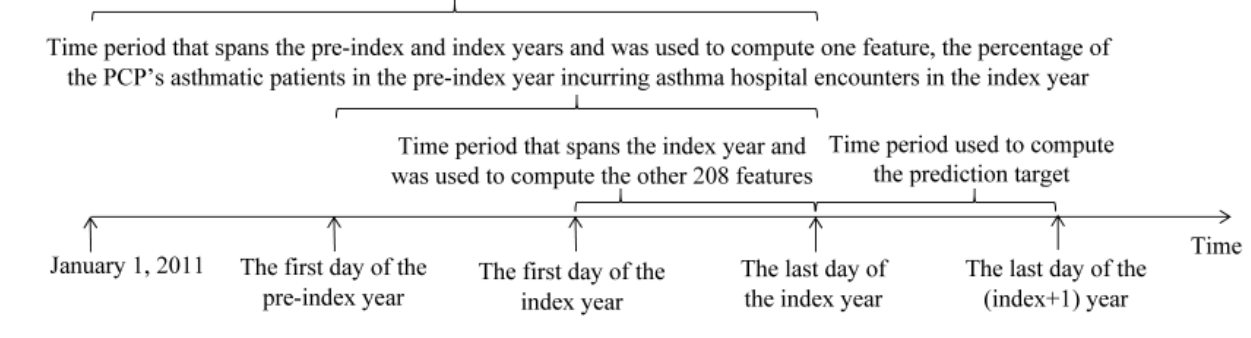
Figure 1. The time periods used to compute the features and prediction target for an index year and patient pair. PCP: primary care